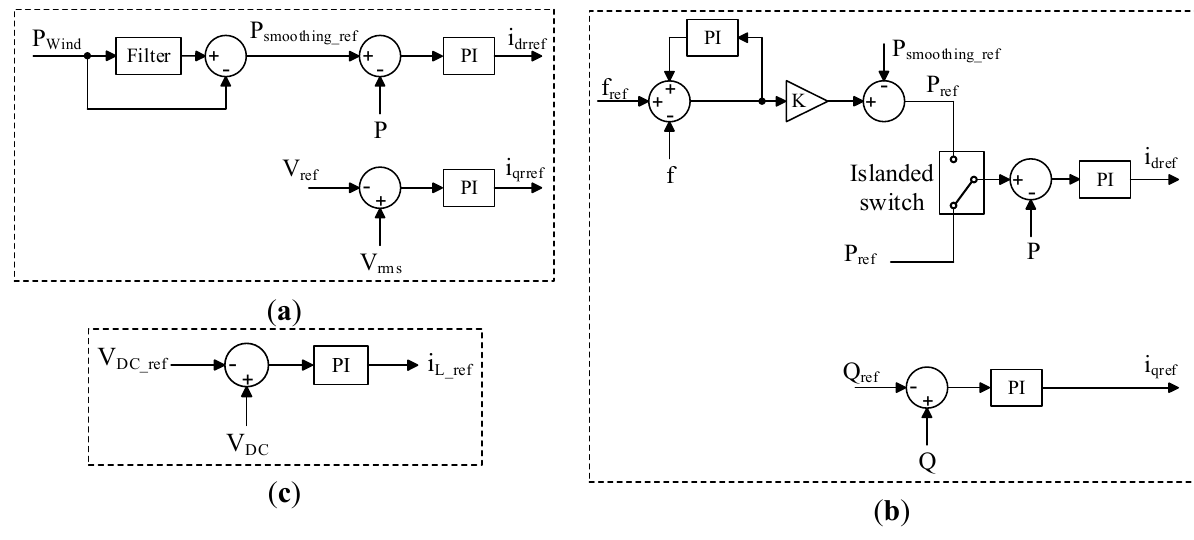
Figure 4. External control systems: ( a ) MSC control system; ( b ) GSC control system; ( c ) battery-side converter control